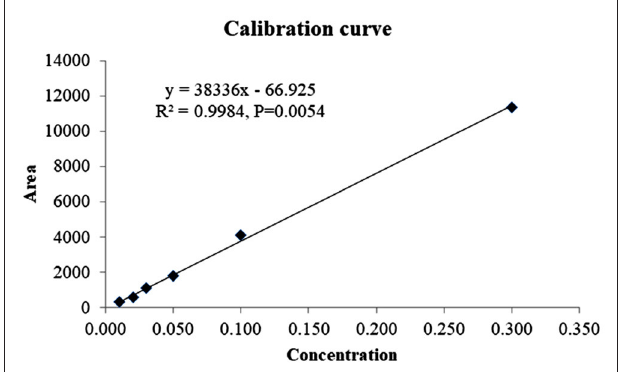
FIGURE 3 | Calibration curve of indoxacarb.